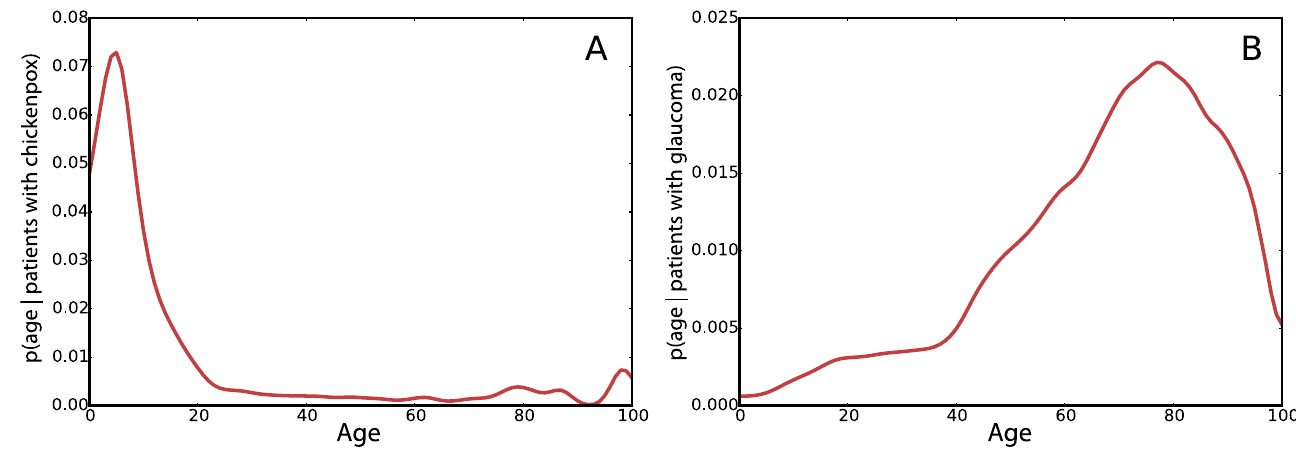
Fig 3. Age distribution for patients with Chickenpox (A) and Glaucoma